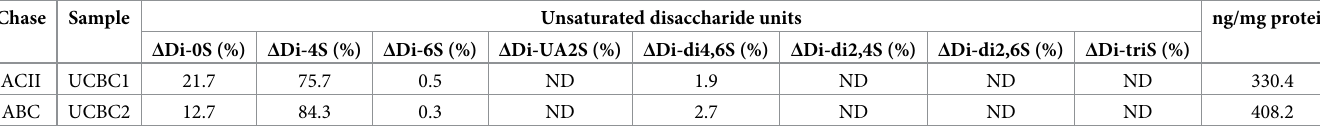
Table 1. Disaccharide composition of CS/DS in GAG from SCE-UCBCs digested with Chase ACII or Chase ABC. Chase Sample Unsaturated disaccharide